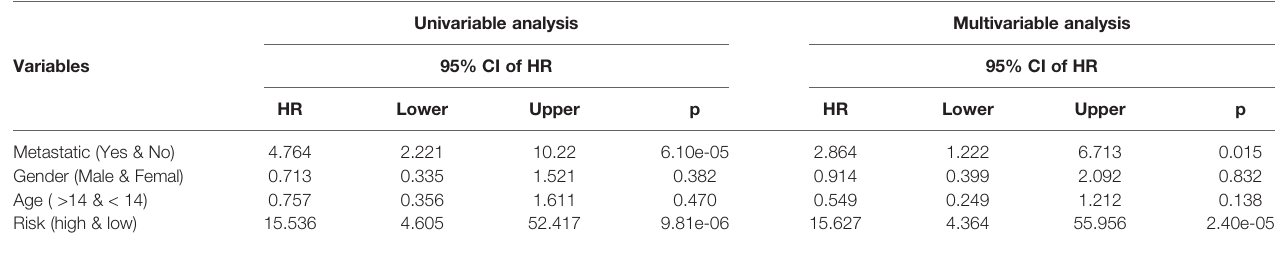
TABLE 1 | Univariable analysis and multivariable analysis of the model and clinical